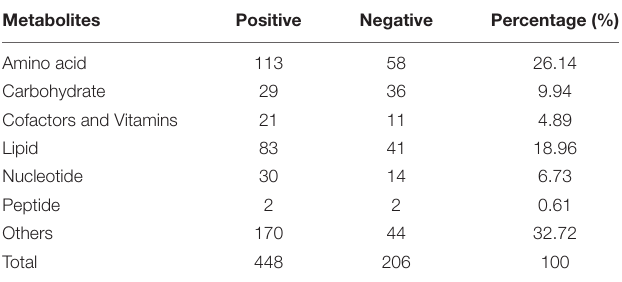
Table 2 ). Molecular weight, Isoelectric point, Domain, Protein Family, Secondary structure of crtI and crtYB genes were statistics ( Table 4 ).